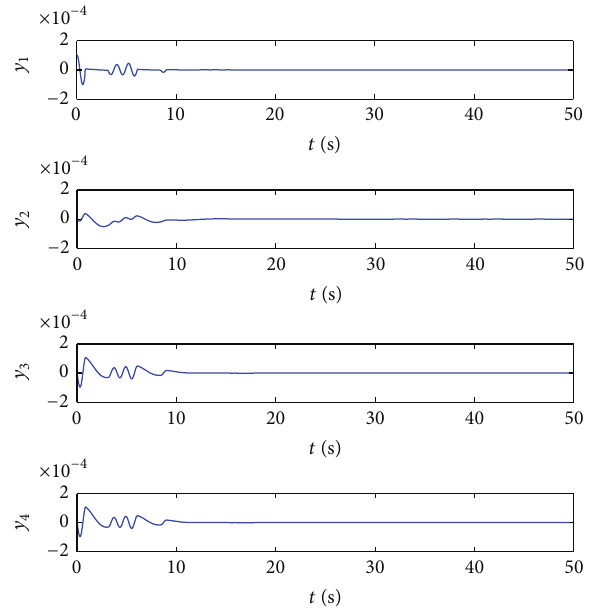
Figure 9: Control to the equilibrium point (0,0,0,−1)